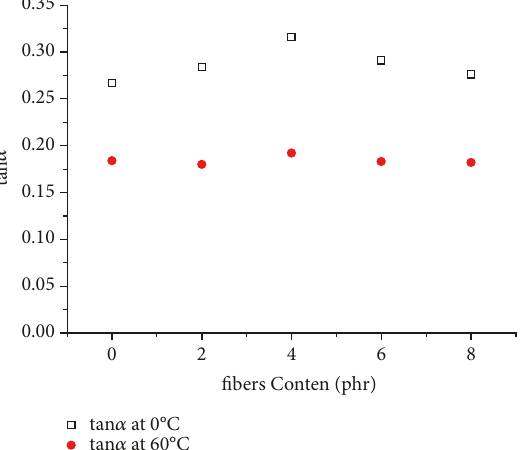
tan  at 0°C tan  at Figure 11: The relationship between MNSF-2 content and tan 𝛿